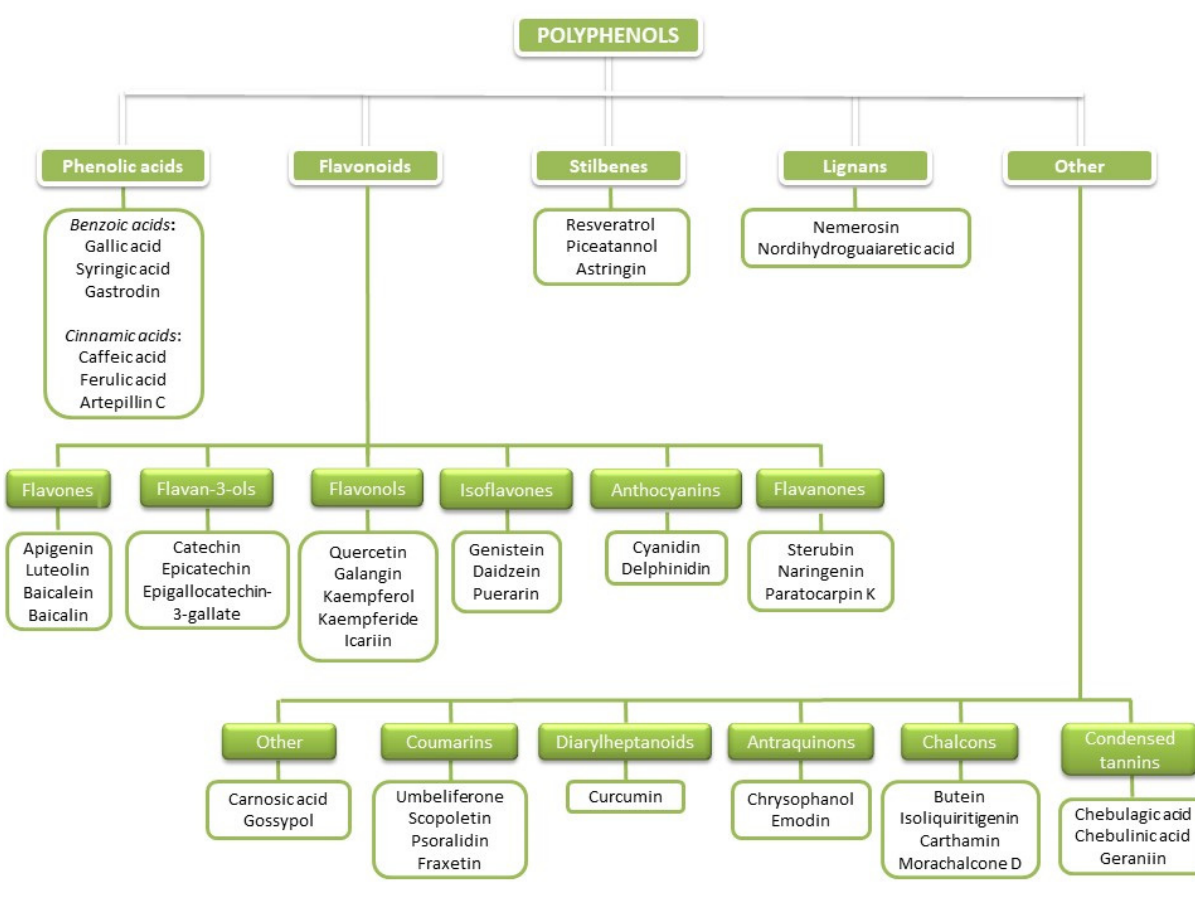
Figure 1. Basic classification of PCs with representatives of particular classes.